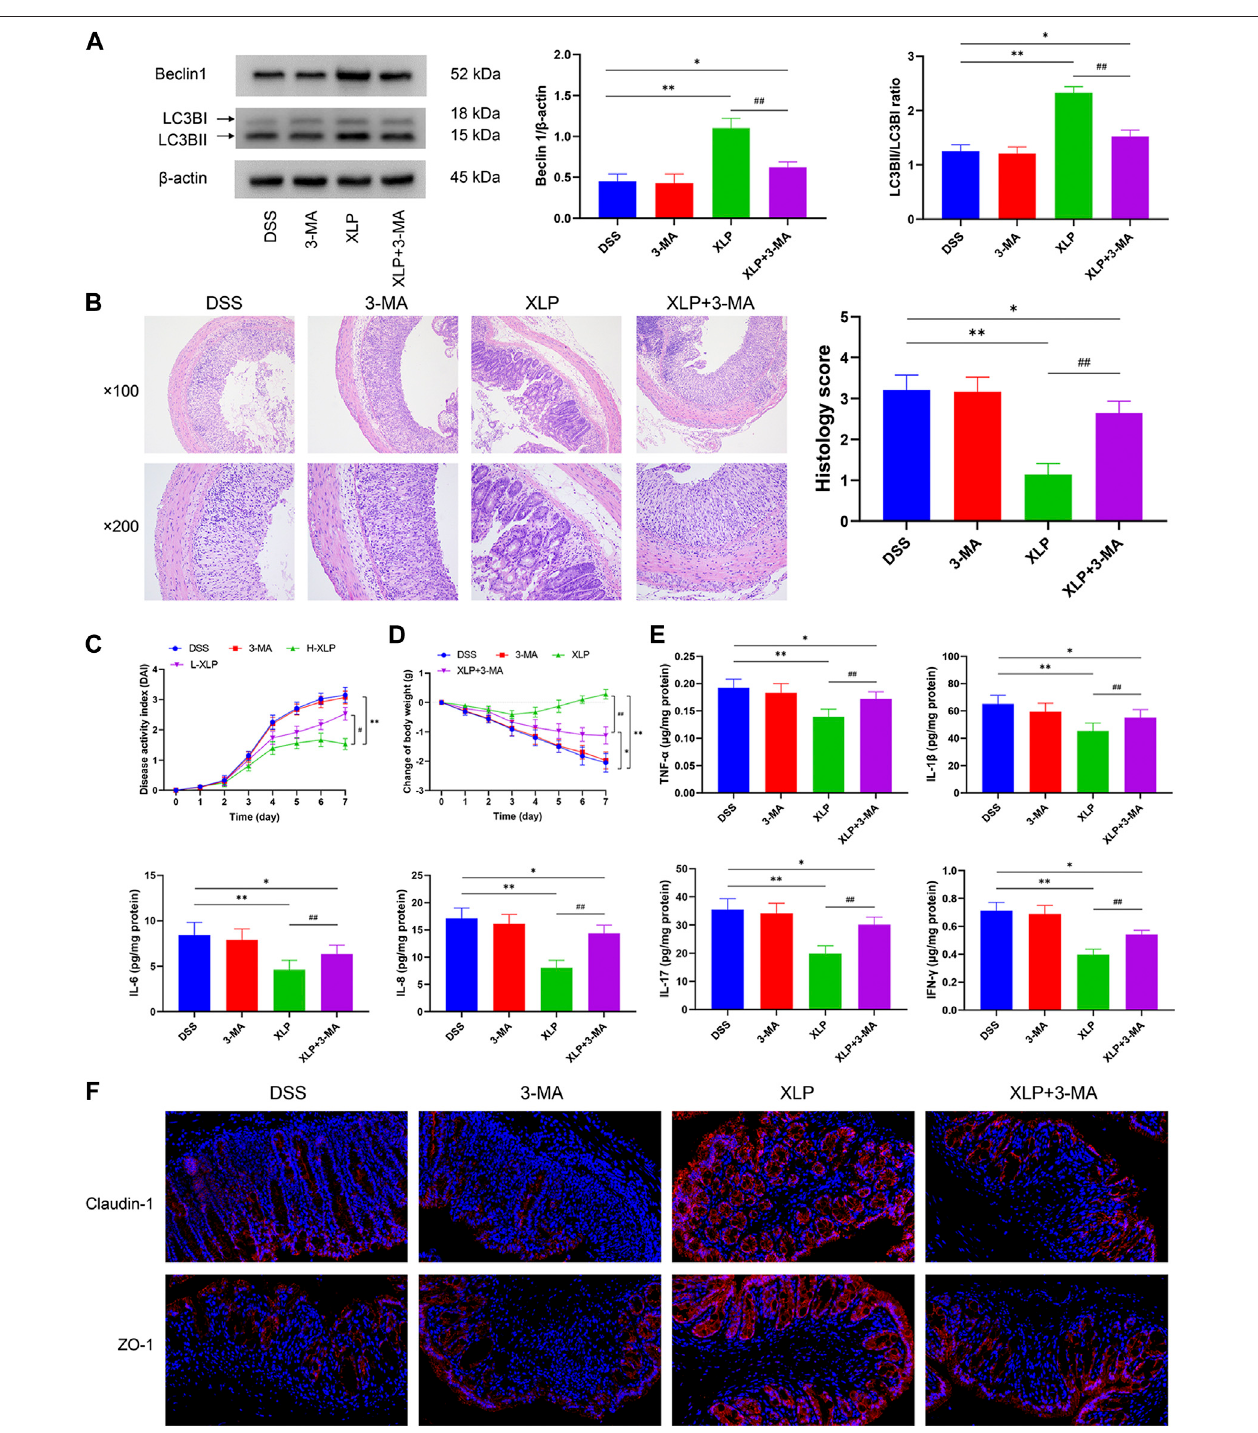
FIGURE6| Inhibition ofautophagyattenuates thepositiveeffect ofXLPon DSS-induced colitisinmice. (A) Expression ofBeclin-1 and LC3Bincolon tissues were detected by western blot. (B) Representative hematoxylin and eosin staining images of colon tissues from each group were performed and observed under a microscope(upperpanel × 100andlowerpanel × 200).Histologicalscoresofcolonswerecalculated. (C) Diseaseactivityindexofmicewerecalculated. (D) Bodyweight of mice were monitored. (E) The levels of TNF- α , IL-1 β , IL-6, IL-8, IL-17, and INF- γ in colon tissues were measured by enzyme linked immunosorbent assay. (F) Colon tissues were stained with claudin-1 or zonula occludens-1 (red) and nuclei-stained with DAPI (blue). Fluorescence images were captured using a fl uorescence microscope ( × 200). * p < 0.05, ** p < 0.01 vs. DSS group, # p < 0.05, ## p < 0.01 vs. XLP group.